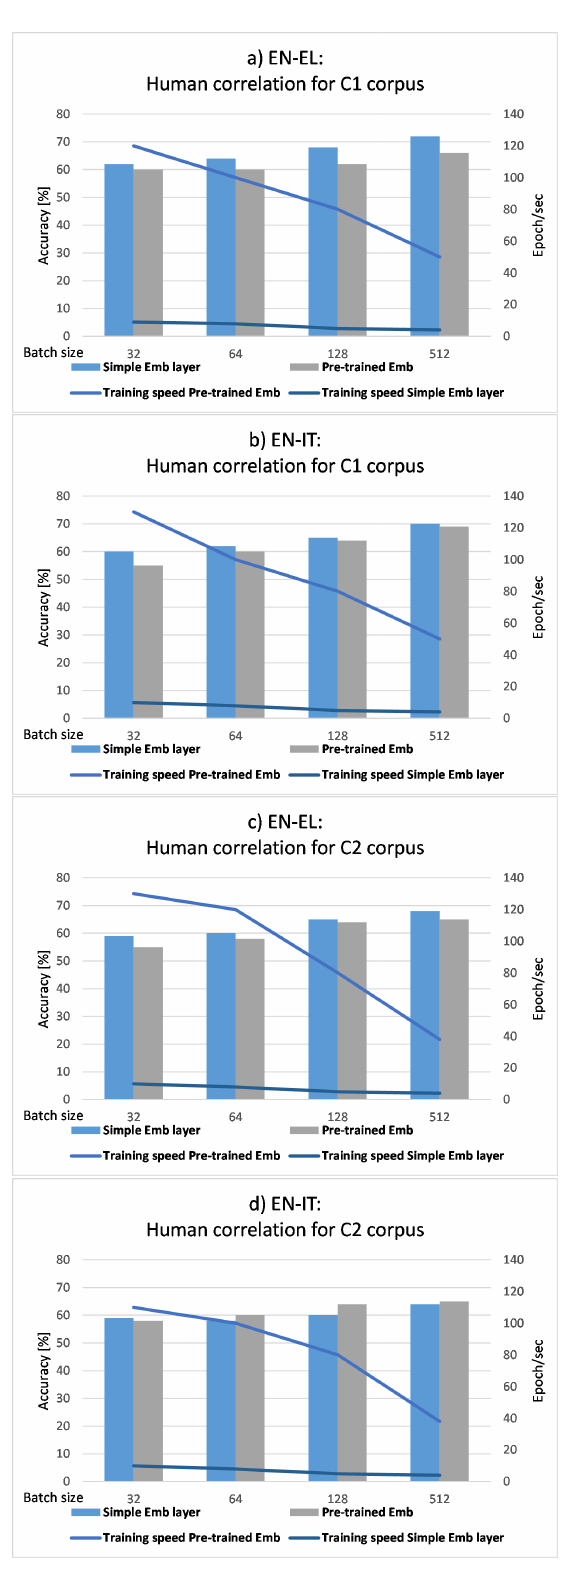
Figure 2. Human correlation. Simple embedding layer vs Pre-trained